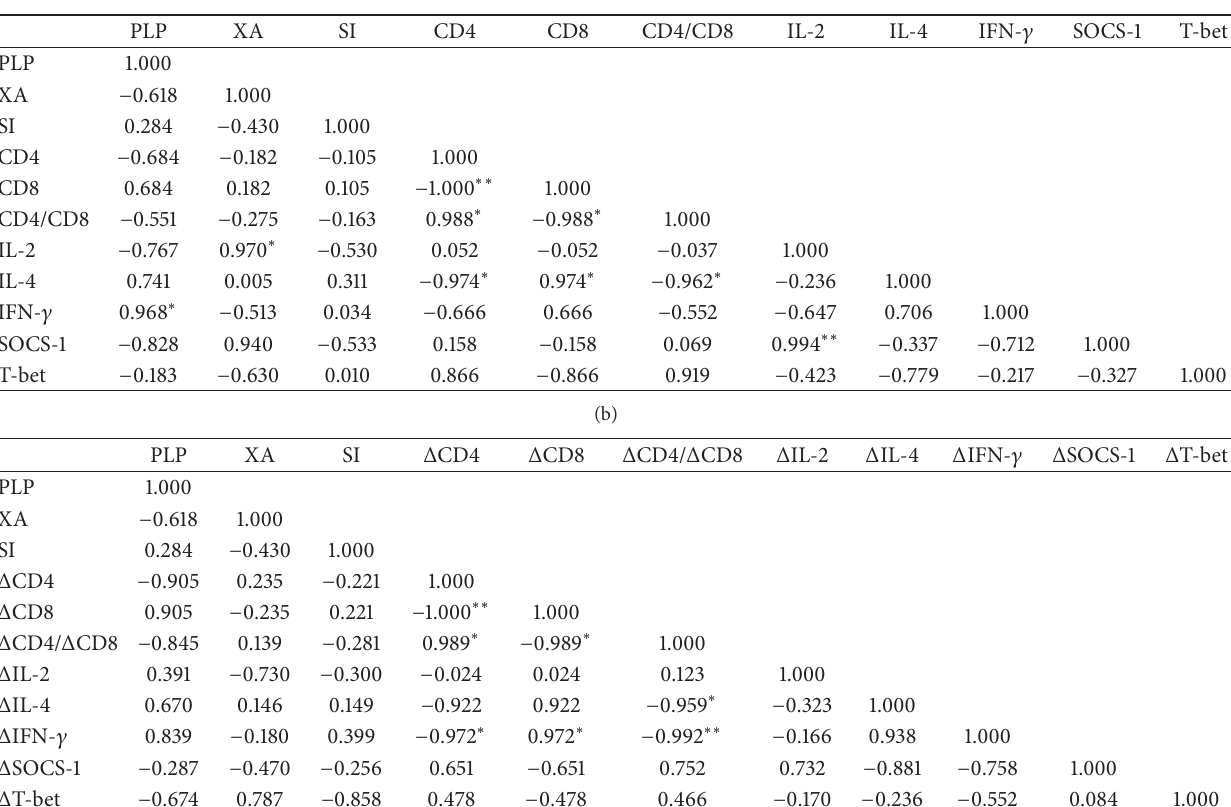
Table 3: Correlations between plasma PLP level in mice and indices of immune